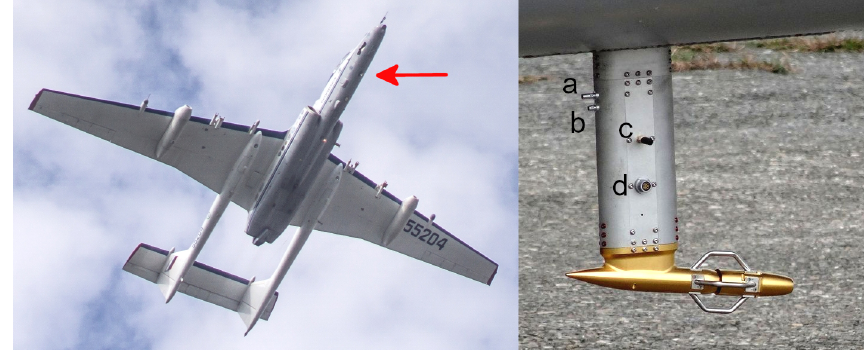
Figure 1. Left: the M-55 Geophysica shortly after takeoff from Tribhuvan International Airport in August 2017. The red arrow points to the sampling inlet of the ERICA. Right: the sampling inlet of the ERICA installed on the aircraft, where (a) is the backing-line exhaust port, (b) the inlet bypass exhaust port, (c) the wireless LAN (local area network) antenna, and (d) the communication